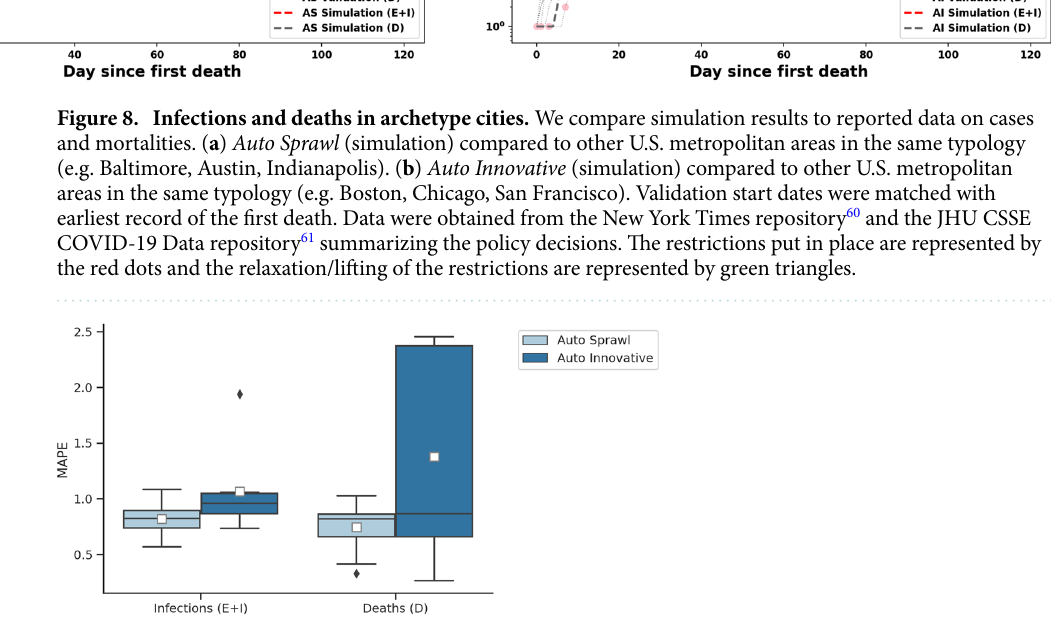
Figure 9. Boxplots showing the mean absolute percentage errors (MAPE) for the simulation output with respect to the observations from the cities in each typology. The MAPE is computed for exposed and infectious cases ( E + I ) and recorded deaths ( D ). The baseline is the day since the first death reported in each